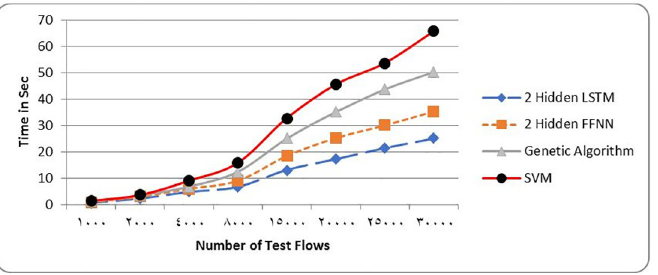
Fig 10. CIC-IDS Time comparison among different classification techniques.